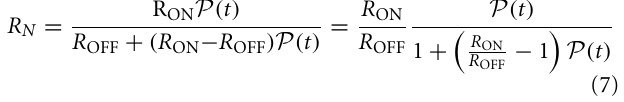
FIGURE 3 | Memristor characteristics of a Co/PZT/LSMO tunnel junction with PZT thickness of 8u.c. (A) Tunneling resistance as function of the writing pulse width. The black data points were measured after each reset pulse, the gray data points after each writing pulse. (B) The applied voltage train of the measuring setup: in this case the amplitude and width of the reset pulse were − 6V and 200ms, respectively, the writing pulse had the same amplitude as the reset pulse. The measurement of the tunnel current is performed with an applied voltage of 0.1V. (C) Normalized ON/OFF ratios for different amplitudes of the write pulse. The lines are fits with Equation (9).